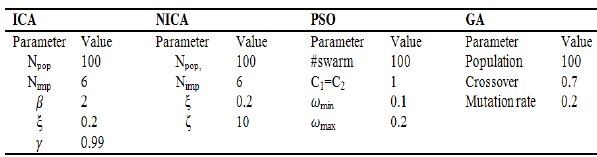
Table 2. parameter values of implemented algorithms